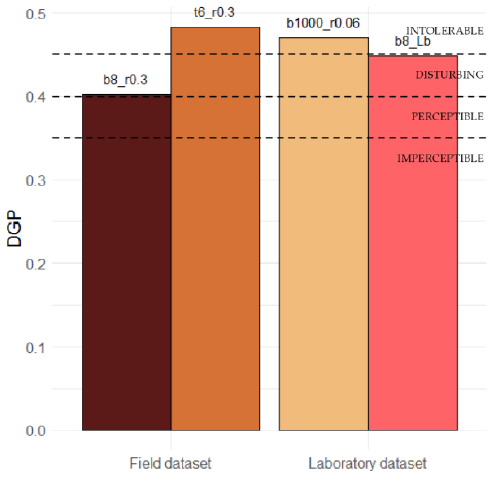
Figure 40. DGP of the same visual scene for different evalglare methods and parameters (field and laboratory studies). Buildings 2018 , 8 , x FOR PEER REVIEW